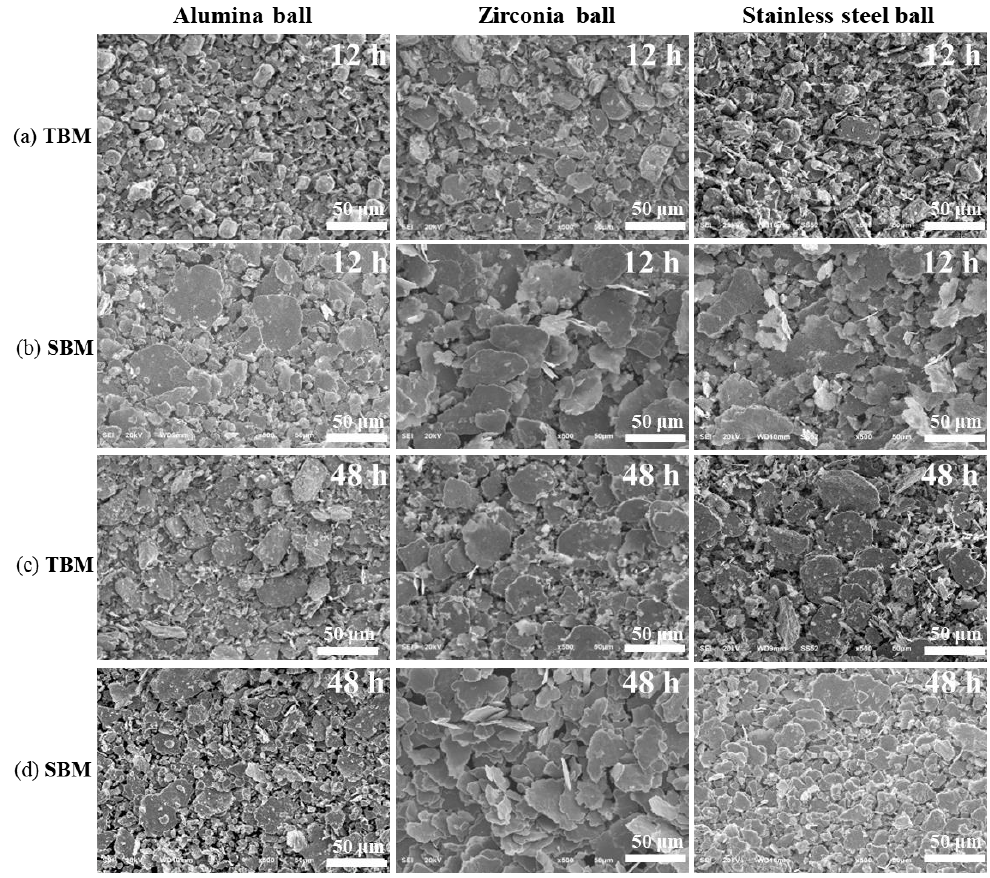
Figure 5. SEM images showing morphologies of Cu/CNT nanocomposites during exposure to different milling media ( a ) 12 h TBM, ( b ) 12 h SBM, ( c ) 48 h TBM, and ( d ) 48 h SBM at 300 rpm.